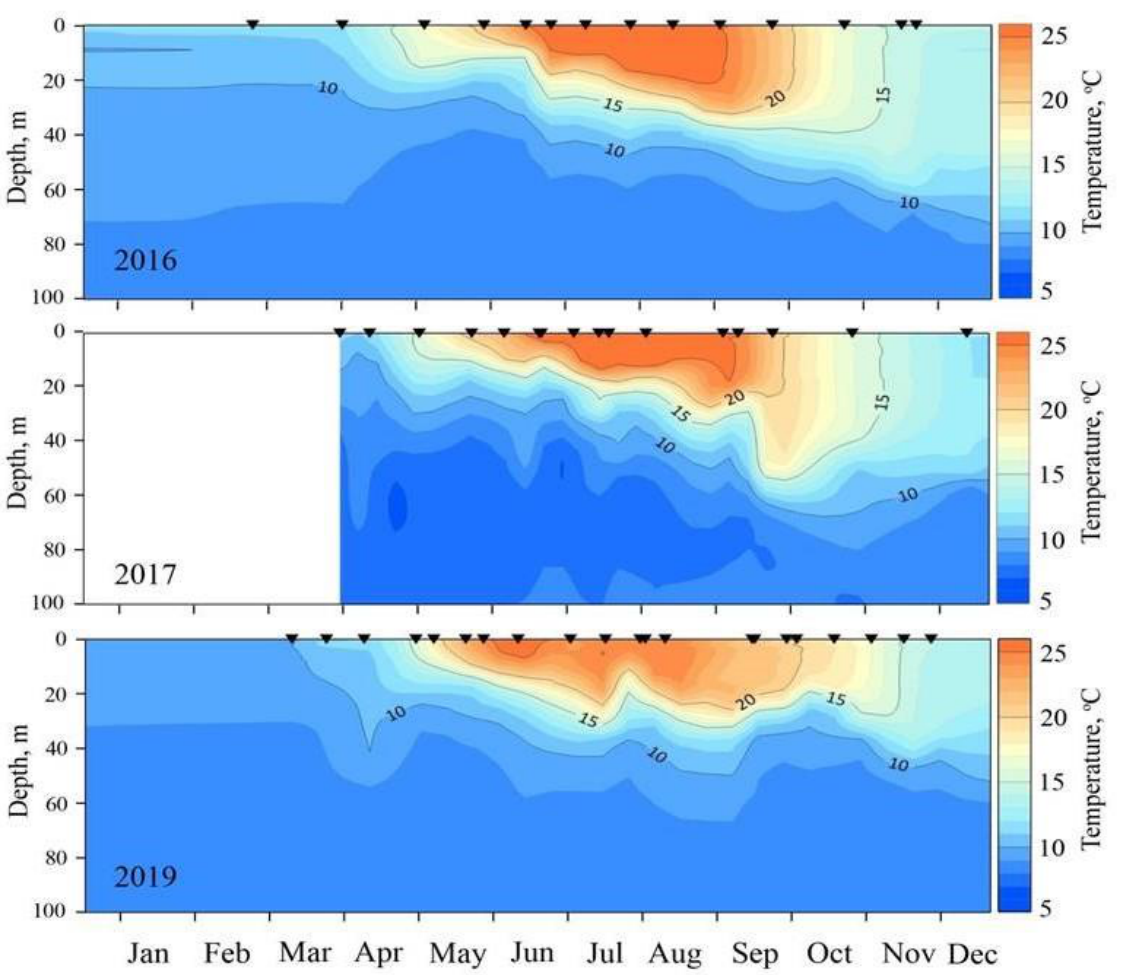
Figure 2. Vertical distribution of temperature at the station above a depth of 500 m in 2016, 2017, and 2019.